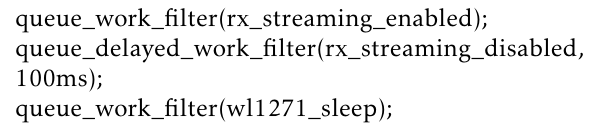
Fig. 6. The implementation of delay transmission using Listen Interval Figure 9. The implementation of delay transmission using Listen Interval Algorithm 1. Listen_interval control algorithm Algorithm 2 when data transmission is completed